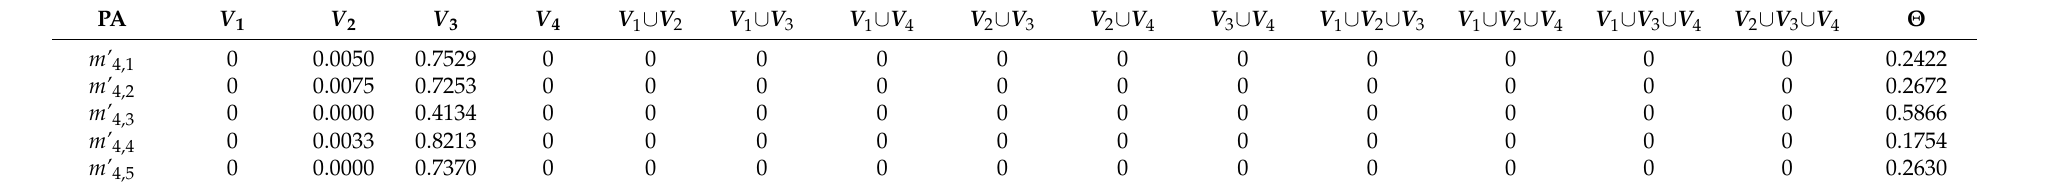
Table 14. Probability assignments of longitudinal crack-transverse crack sub-classifier for an image of a transverse